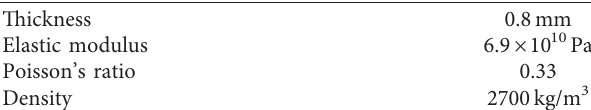
Figure 2: Scheme of the U-Net architecture. PredictedTrue Figure 3: Representation of true and predicted damaged regions. Table 1: Skin characteristics.